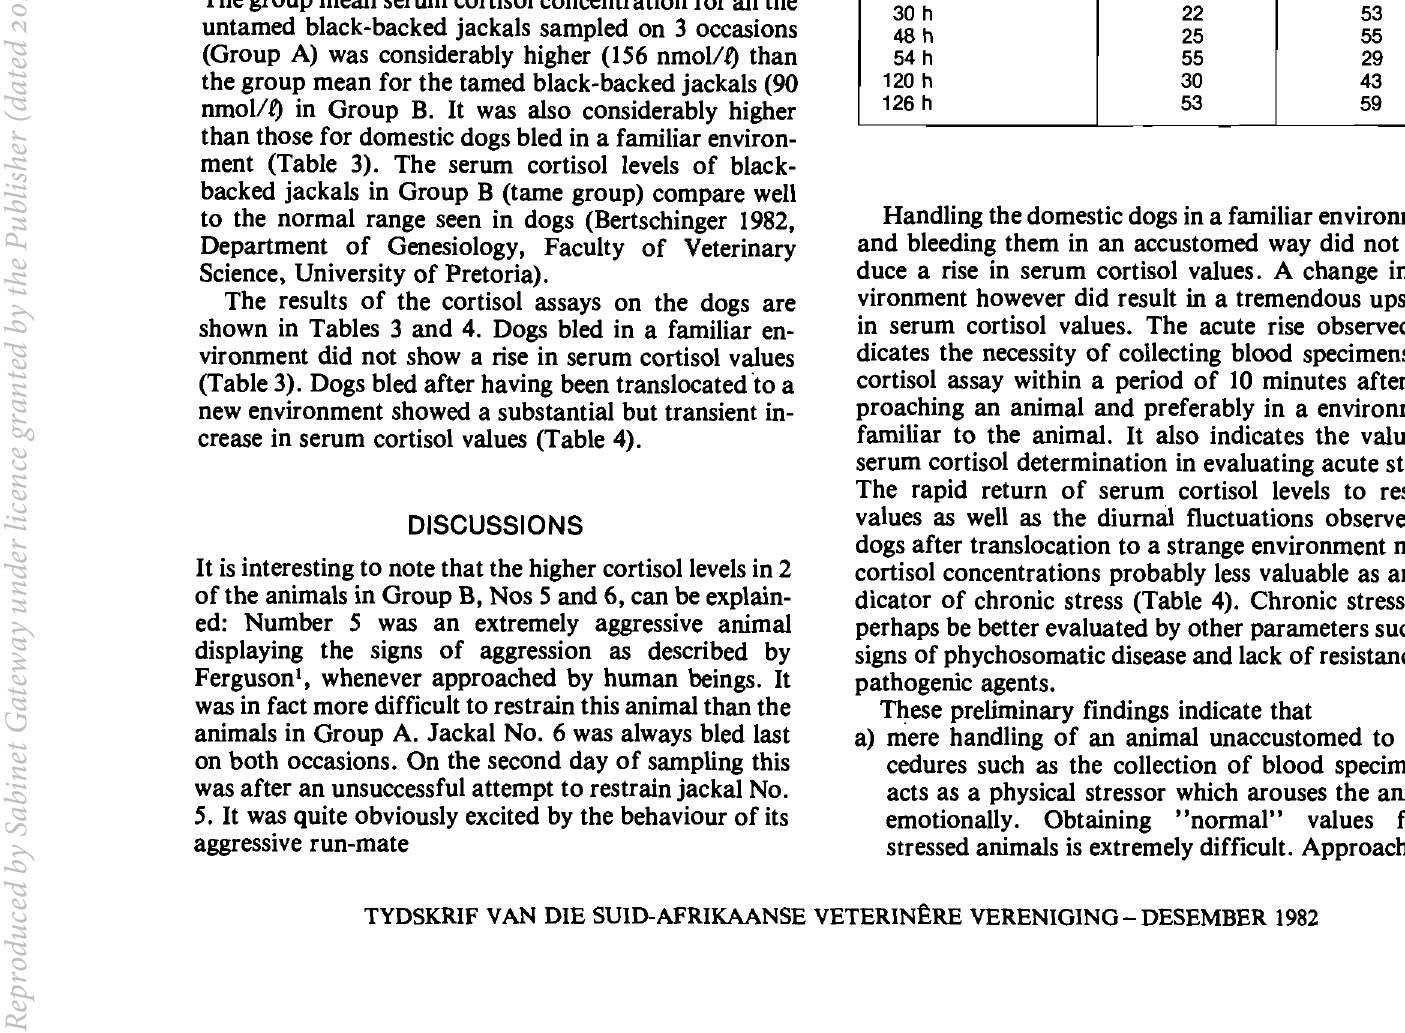
Table 4: SERUM CORTISOL LEVELS IN DOGS AFTER TRANSLOCATION TO A STRANGE